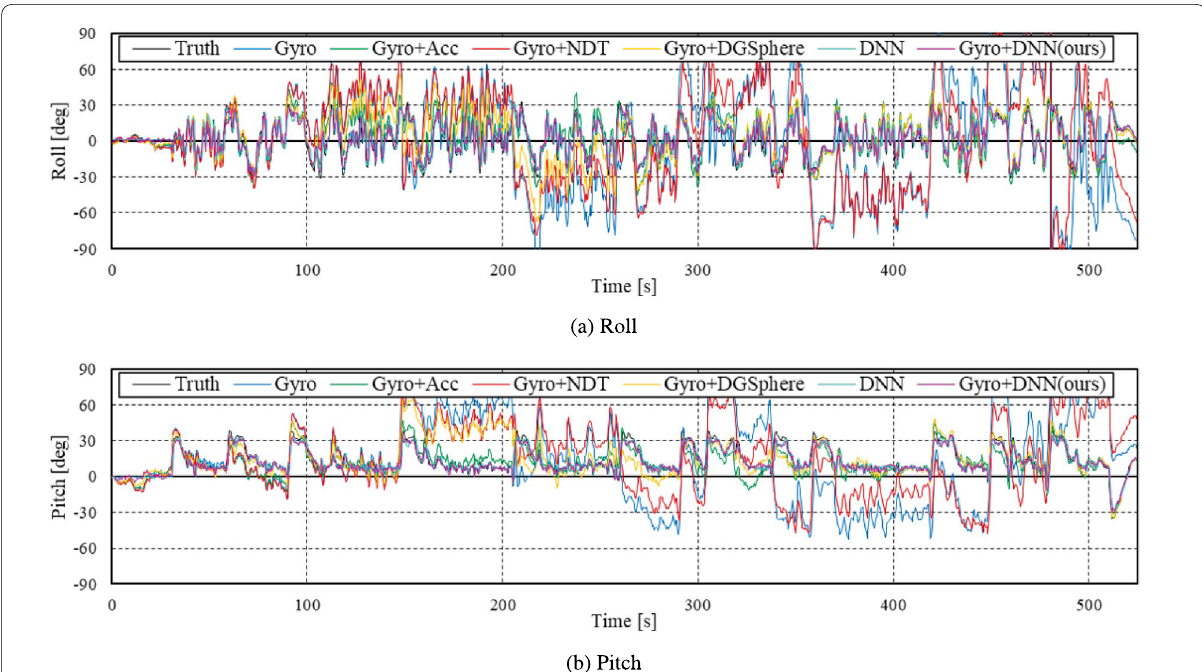
Fig. 12 Real-time plotting in ‘Neighborhood’. ‘Gyro